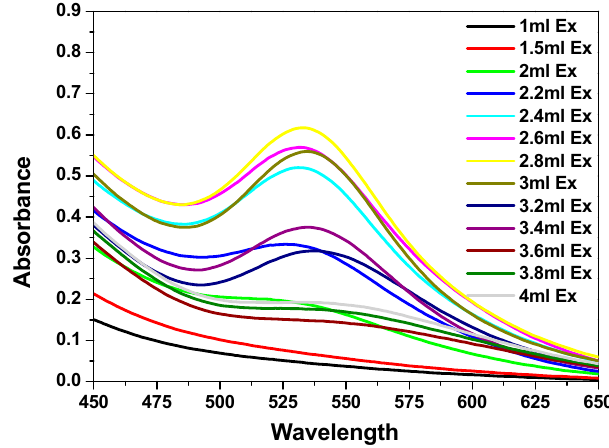
Figure 1. UV–visible spectra of Au nanoparticles (NPs) formed after 1 h in the presence of different volumes of Corchorus olitorius (mallow) leaf extract (1–3.4 mL) and 0.5 mL of (0.01 M) HAuCl 4 .3H 2 O.